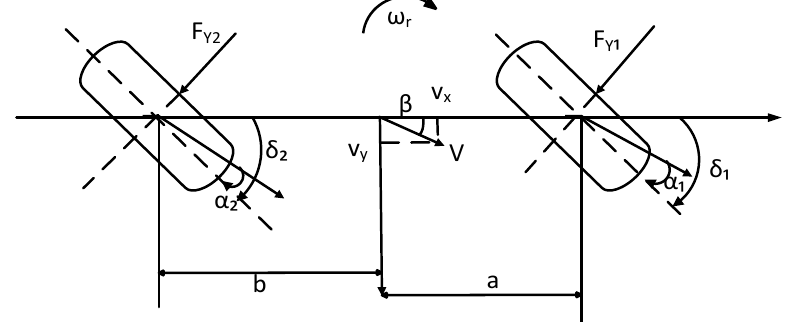
Figure 1. Two-degree-of-freedom model of four-wheel steering. The major parameters are given as follows: F Y 1 and F Y 2 are the lateral forces of the front and rear wheels, respectively; δ 1 and δ 2 are the front and rear steering angle, respectively; α 1 and α 2 are the side angles of the front and rear wheels, respectively; ω r is the yaw rate of the vehicle; β is the side slip angle of the vehicle; v x is the longitudinal speed of the vehicle; v y is the lateral speed of the vehicle; I z is the yaw moment of inertia around the center of mass; a and b are the distances from the center of gravity to the front and rear axles,